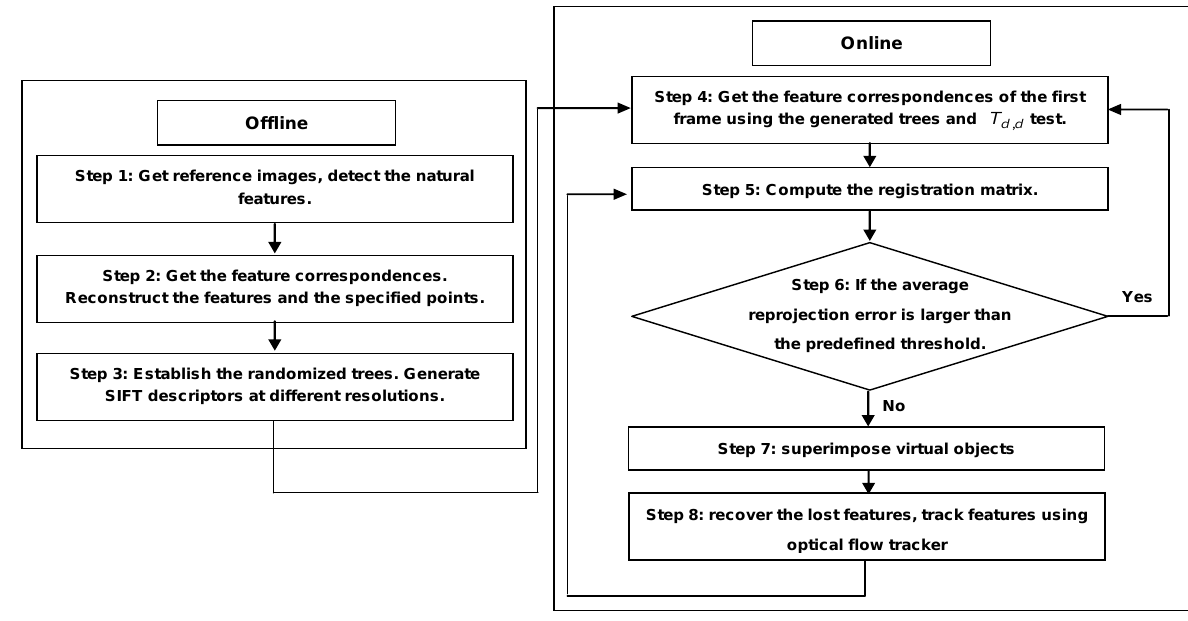
Figure 3. Flowchart of the proposed registration